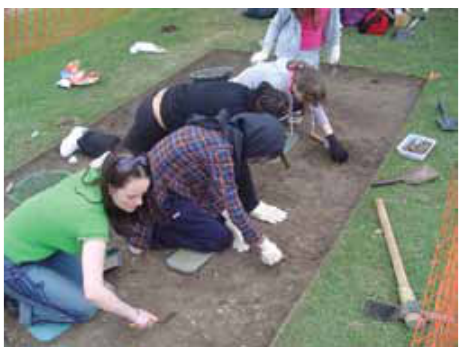
Fig. 2: Hendon School students learning about archaeological plan drawing with Sarah Dhanjal and Angela Hol- mes of HADAS.